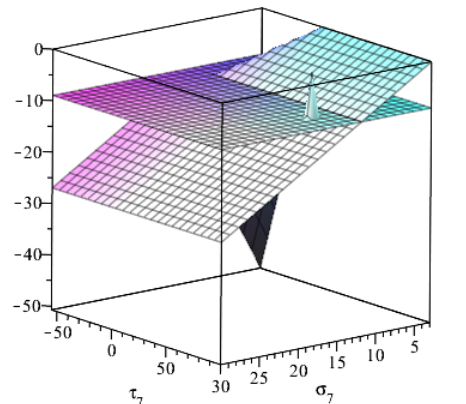
Figure 5 . Comparison between the lowest eigenvalue of R 2 in this case. There are regions of stability for values of (cid:27) 7 close to 3, which correspond to R 2 and to negative values of V 0 . The example displayed here refers to (cid:12) = (cid:0) 1 and ‘ = 1, which corresponds to the minimum in the heterotic case of (cid:12)gure 4, and the peak identi(cid:12)es the point corresponding to the tree-level values (cid:27) 7 = 15, (cid:28) 7 = 75.